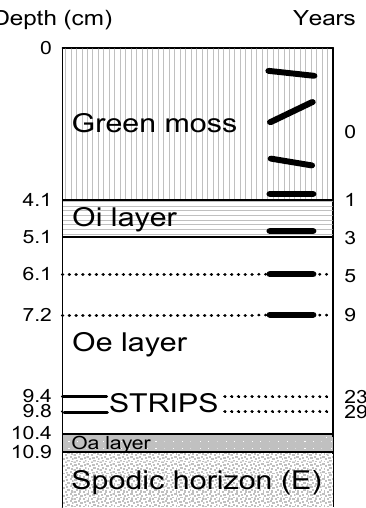
Figure 9. Vertical position of spruce needles in the moss-covered soil profile after different number of years. It took about one year to be transported through the 4 cm thick layer of living, green moss and two additional years to pass the 1 cm thick litter layer (Oi). Five year old needles had sunk 1 cm into the fermentation layer (Oe) and nine year old needles only one more cm. Nylon strips, recovered after 23 and 29 years still had not reached the humus layer (Oa). Modified from [16]. The depth of the cones was measured after 9, 11 and 13 years. After 9 years in the moss-covered forest floor, the upper cone surface was 2.5 cm below the bottom of green moss and 3.3 cm below after 11 and 13 years. Since cones were 2.5 cm thick, the latter position means that the underside was 5.8 cm below the bottom of green moss. The actual site had a 2 cm thicker Oe layer than in Figure 9, so the centre of the cone was situated in the middle of the Oe layer. Fine roots surrounded the cone [16].